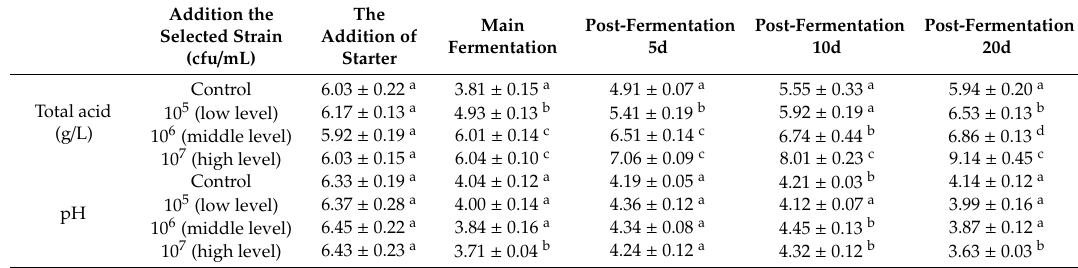
Table 2. Changes in the total acid and pH in the Chinese rice wine adding di ff erent level of L. plantarum CAU 3823 at the post-fermentation and main fermentation stage during di ff erent fermentation stages (addition of starter; main fermentation; post-fermentation 5d; post-fermentation 10d; post-fermentation 20d).